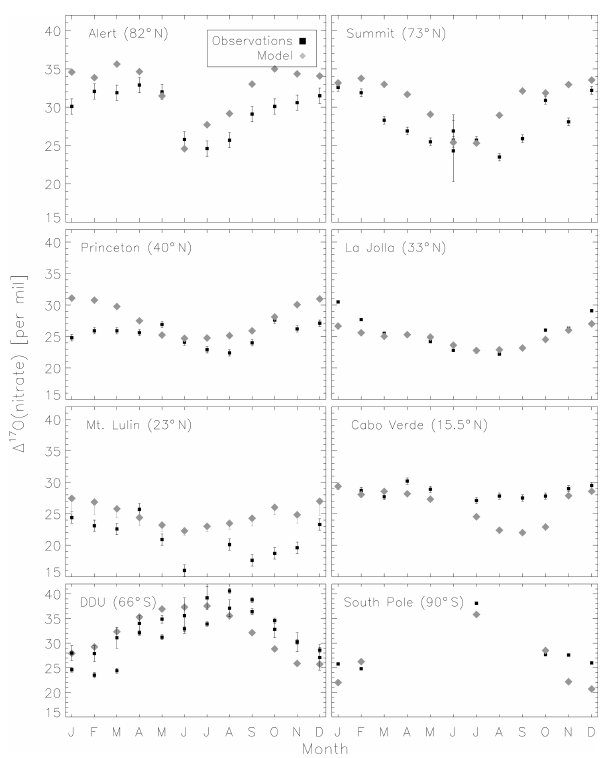
Figure 6. Comparison of monthly-mean modeled (cloud chemistry) and observed (cid:49) 17 O(nitrate). Error bars for model results from Mt. Lulin reflect the range of possible modeled A values for nighttime reactions as described in the text. Error bars for the observations re- flect the analytical uncertainty in the measurements, except for two data points in June for Summit which reflect the standard deviation of (cid:49) 17 O(nitrate) from multiple measurements during that